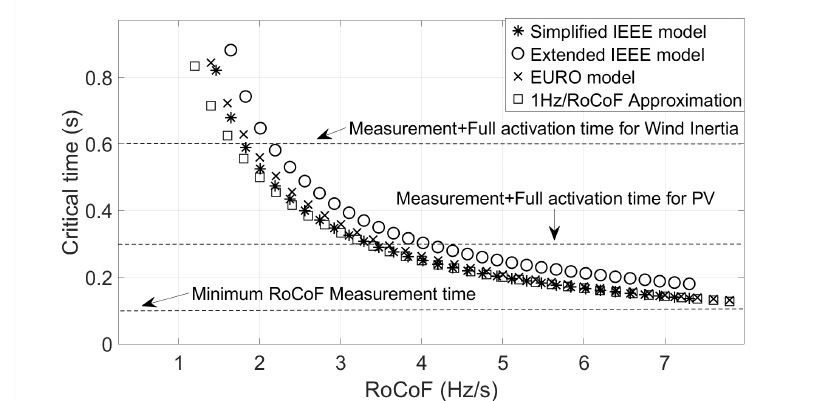
Figure 9. Results for critical time in all simulated models with a penetration of IBG of